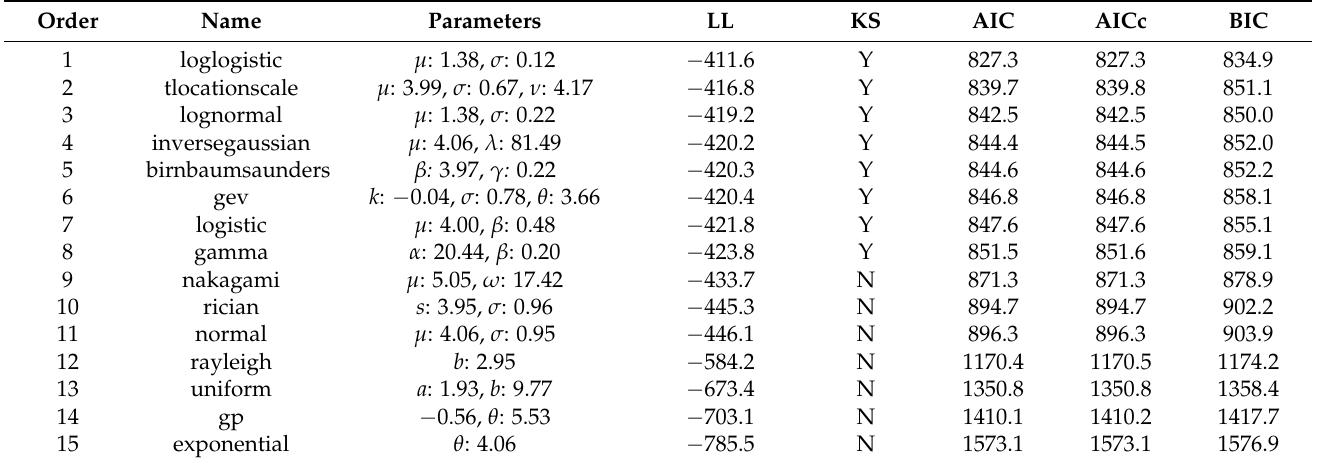
Table A3. Probability Distribution Rankings Using Different Goodness-Of-Fit Tests for Cluster.